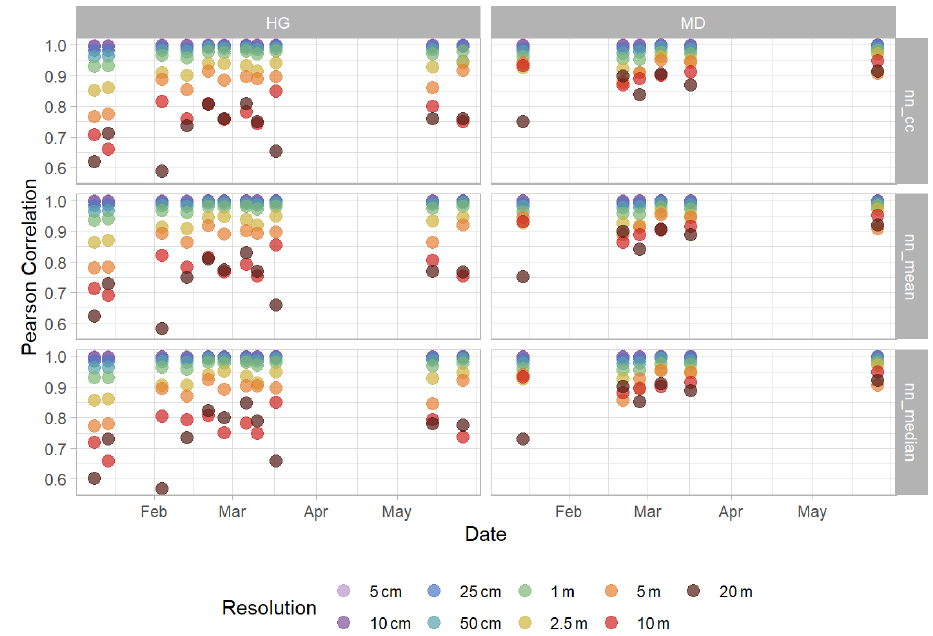
Figure A2. Pearson correlations of nearest neighbor (nn), cubic convolution (cc), aggregated mean (mean), and aggregated median (median) resampled snow depth residuals for the Hourglass (HG) and meadow (MD) locations for each field day. Each row represents nearest-neighbor correlations with cubic convolution (top), aggregated mean (middle), and aggregated median (bottom). Colors represent different snow depth DSM resolutions.